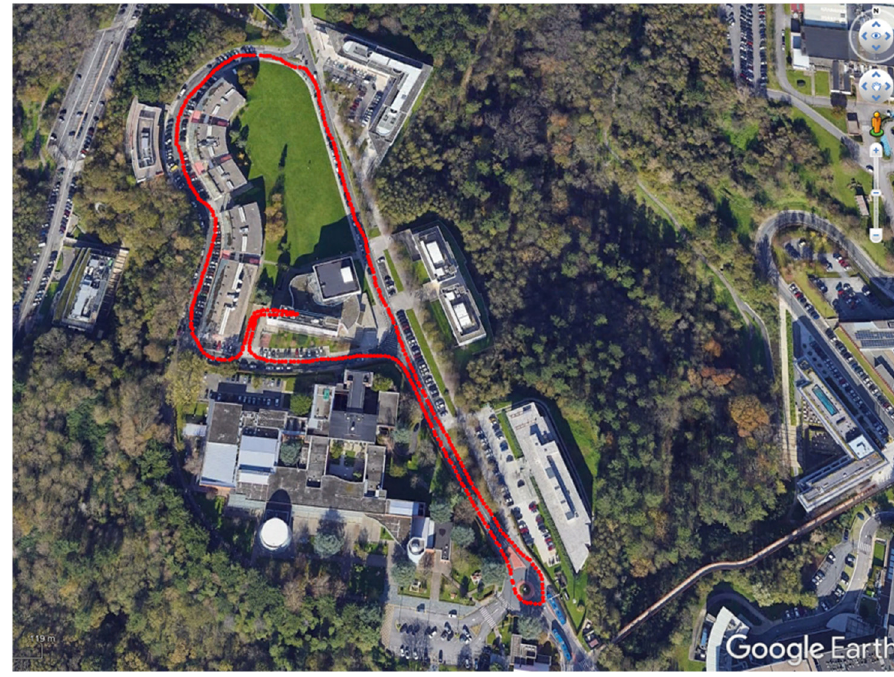
Figure 4. Complete view of the measurement site and performed trajectory.